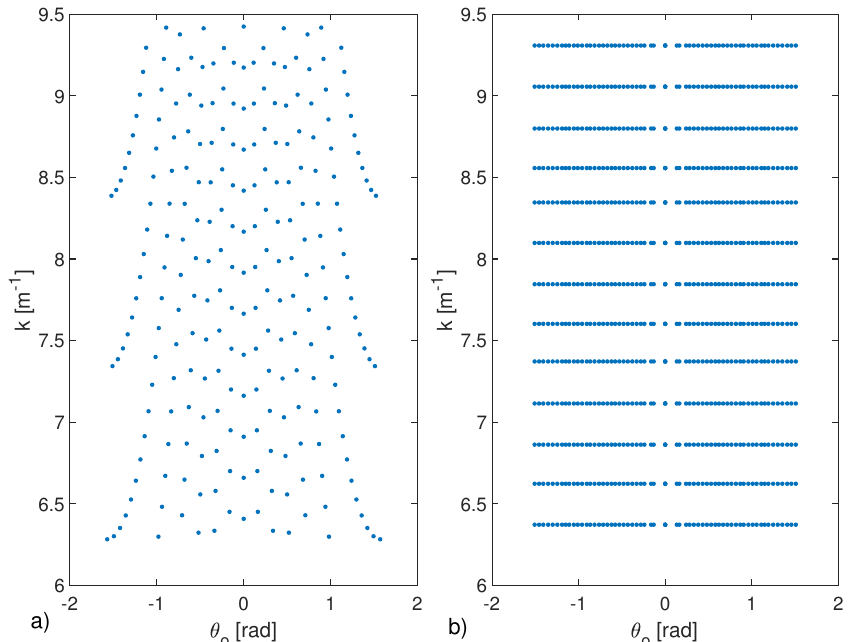
Figure 7. Optimal (panel ( a )) and suboptimal (panel ( b )) sampling grid. The parameters are the same as panel ( b ) of Figure 6. In this case, N = 241, while P = 61 and Q =